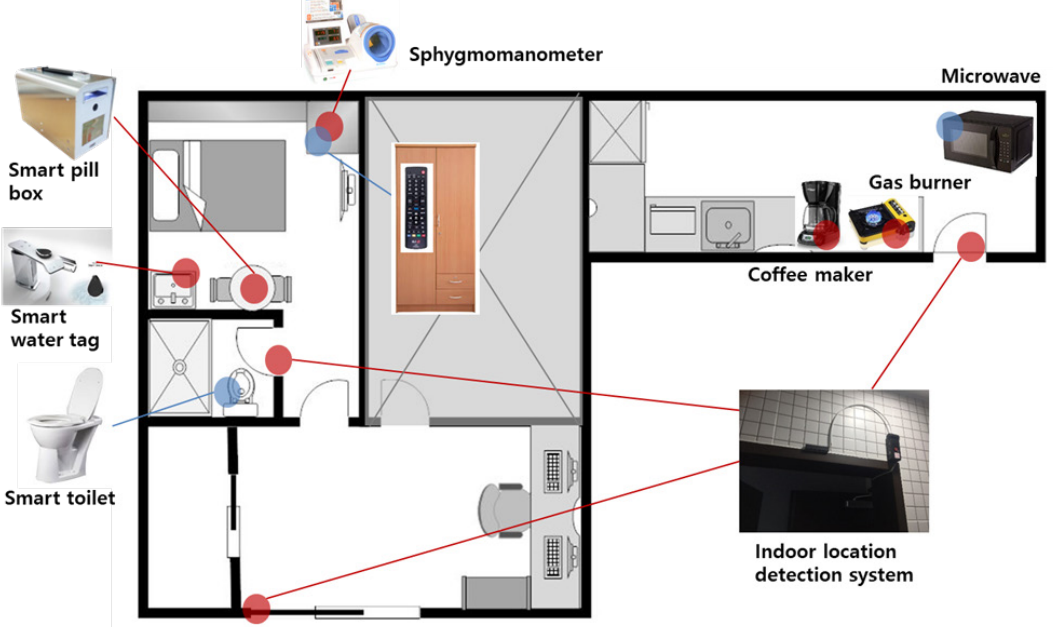
Figure 1. Activity of Daily Living (ADL) Device Layout for Pilot Test.